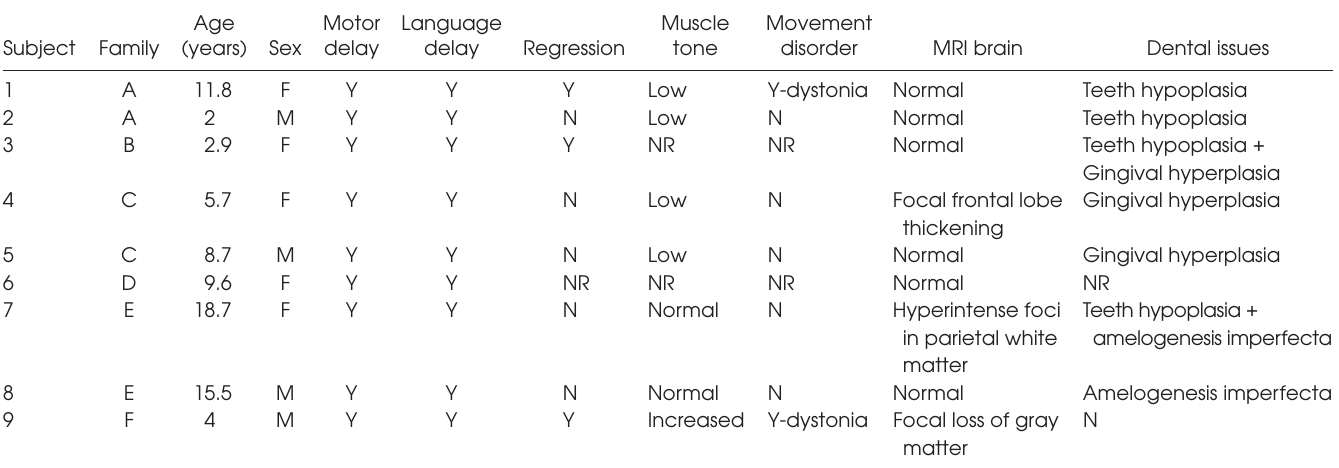
table 2. Background and basic neurodevelopmental information on children with SLC13A5 mutations in this study.